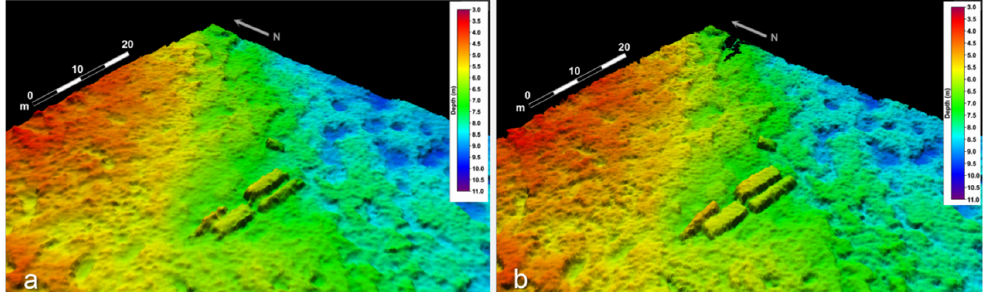
Figure 11. A 3D bathymetric data rendering across wreck site 1. Data are gridded at 0.25 m. ( a ) Surface creation is based on data regularly gridded and weighted; ( b ) Surface creation is based on the shoalest soundings contributing to a node at their true position. The length scale refers to a planar distance at the centre of the image.